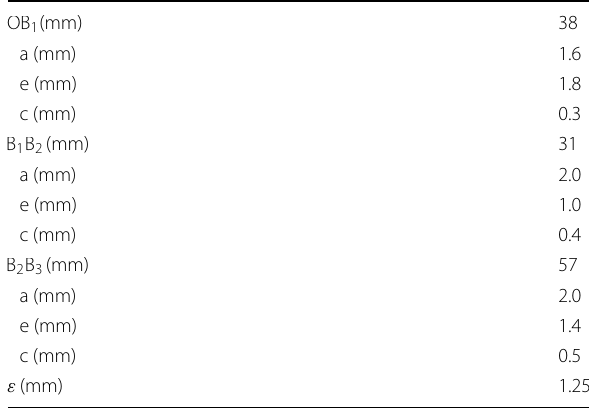
Table 2 Slit parameters and errors of the 6 mm inner pipe